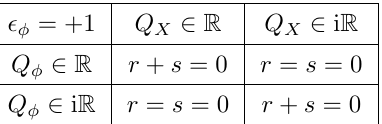
Table 3 . Conditions on the integers r and s for a spacelike (cid:30) following from the Hermiticity of X . Hermiticity of (cid:30) does not impose further